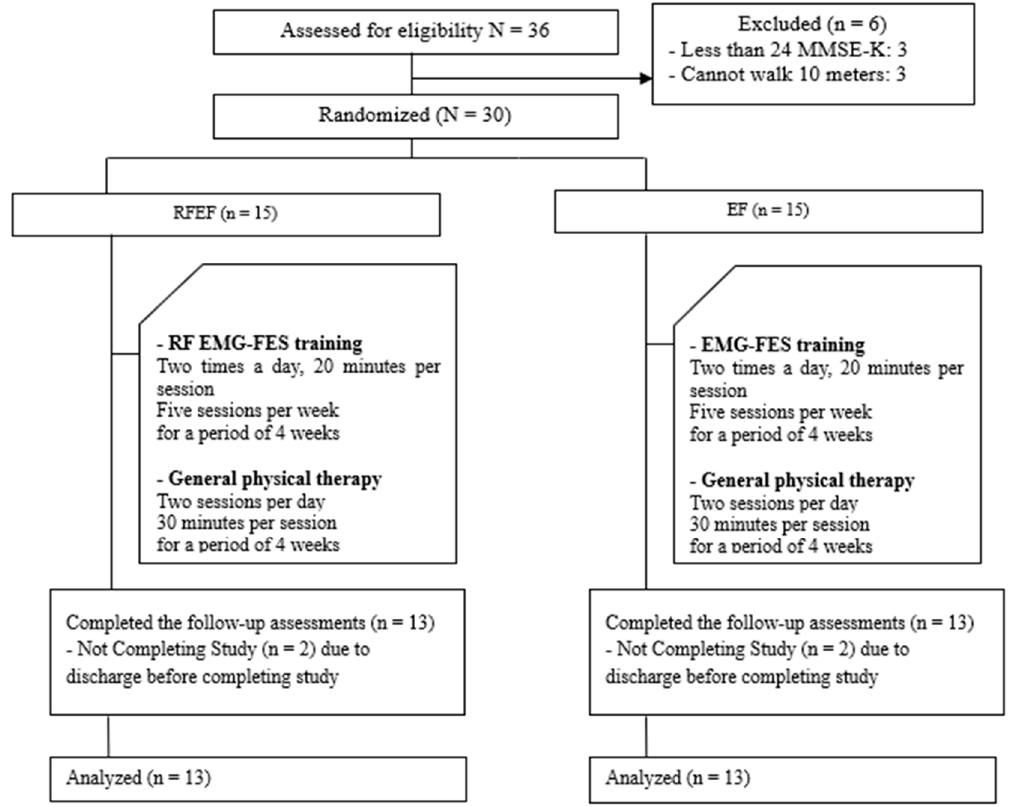
Figure 1. Schematic of the study design. Real-time feedback (RF) electromyography–functional electrical stimulation interface (EMG–FES interface) = EMG–FES interface combined with real-time feedback on ankle joint training.